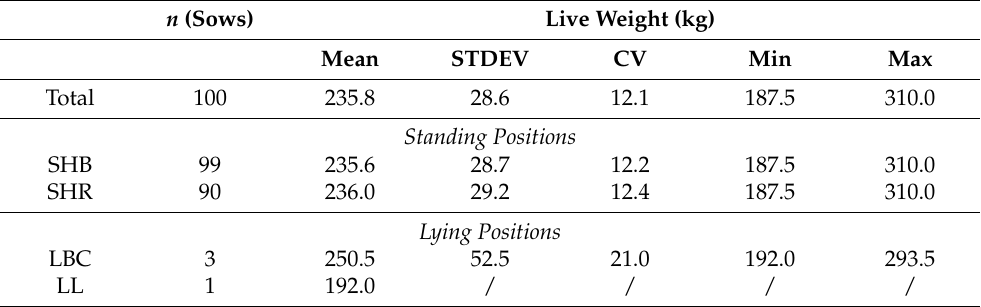
Table 6. Measured weights of sows according to body position groups (with SHB = Standing head bowed, SHR = Standing head half or fully raised, LBC = Lying in belly chest position, LL = Lying in the lateral position, STDEV = Standard Deviation, CV = coefficient of variation, Min = minimal value, Max = maximal